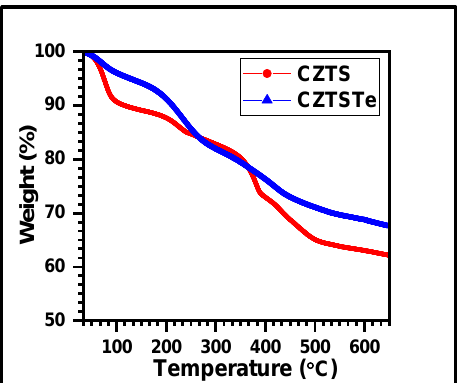
Figure 6. Thermogravimetric analysis (TGA) spectra of CZTS and CZTSTe nanoparticles.